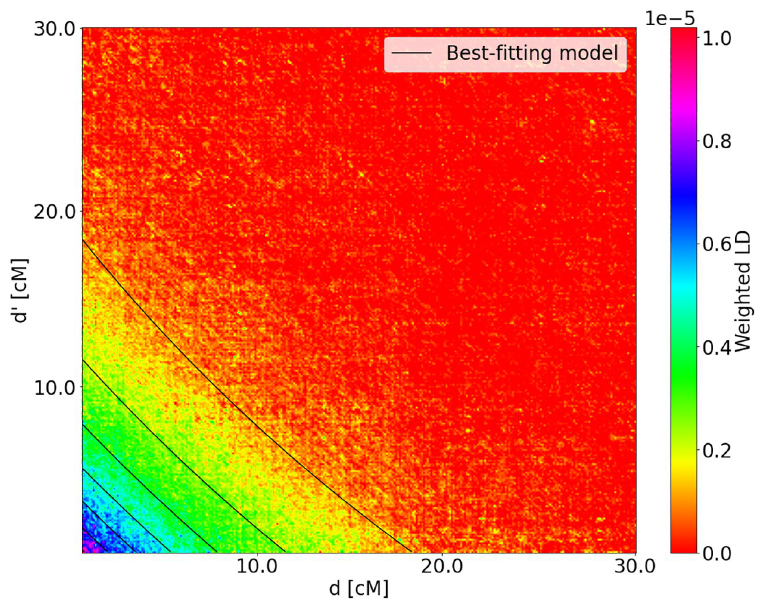
Fig 7. Weighted LD surface for Mexican samples with Yoruba as the first source population reference. The model with the best fit is two pulses from the non-Yoruba source population at T 1 + T 2 = 13.2 ± 1.01 and T 2 = 7.9 ± 0.99 generations ago. The weighted LD surface was estimated from real data, the level lines correspond to the best-fitting model inferred by LaNeta method.